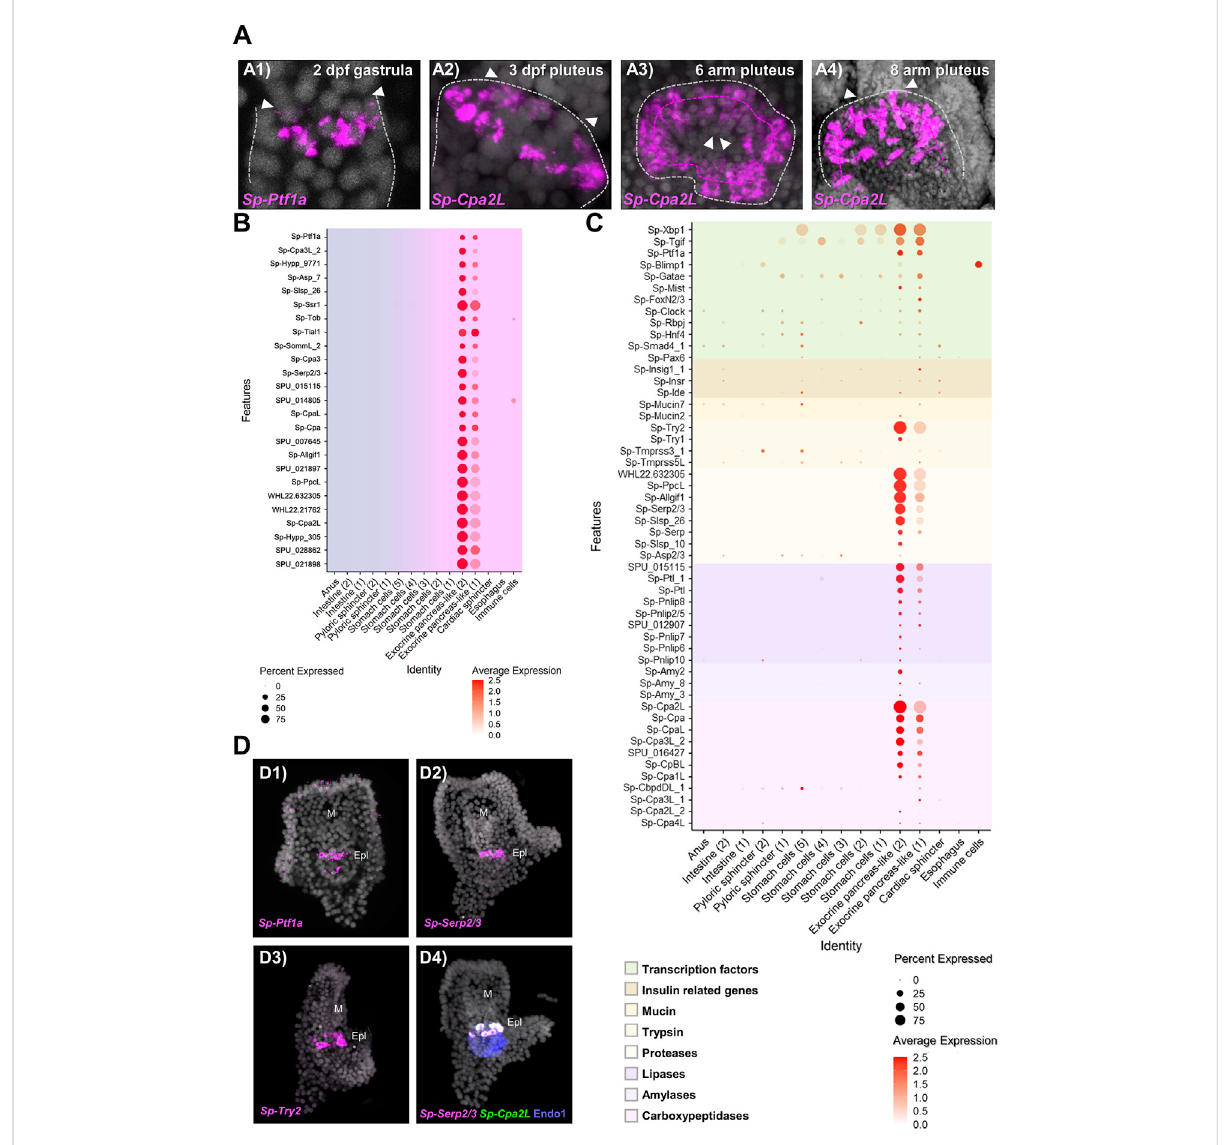
FIGURE 3 Molecular characterization of the S. purpuratus larva exocrine pancreas-like cells. (A) FISH using antisense probes against Sp-Ptf1a (A1) and Sp- Cpa2L (A2 – 4) at gastrula and various larval stages, respectively. Contour of the digestive tract compartment (gray) and thedouble belt row structure (magenta) are shown indotted lines. Arrowheadsindicate theposition of thepresumptive (A1) and theactual cardiac sphincter (A2 – 4). Specimensin A1,A2,andA4areorientedinlateralviewandthelarvainA3isviewedfromthecardiacsphincter. (B) Dotplotshowingtheaverageexpressionof thetop25exocrinepancreas-likemarkergenes. (C) Dotplotshowingtheaverageexpressionofseaurchin orthologousgenesencodingforproteins found in mammalian acinar cells. (D) FISH validations of gene predictions shown in (C) using antisense mRNA probes for Sp-Ptf1a (D1), Sp-Serp2/3 (D2, D4), Sp-Trypsin2 (D3) and Cpa2L (D4). FISH shown in D4 was paired with IHC for the midgut and posterior gut marker Endo1. DAPI was used to label the nuclei (gray). Epl, Exocrine pancreas-like; M,